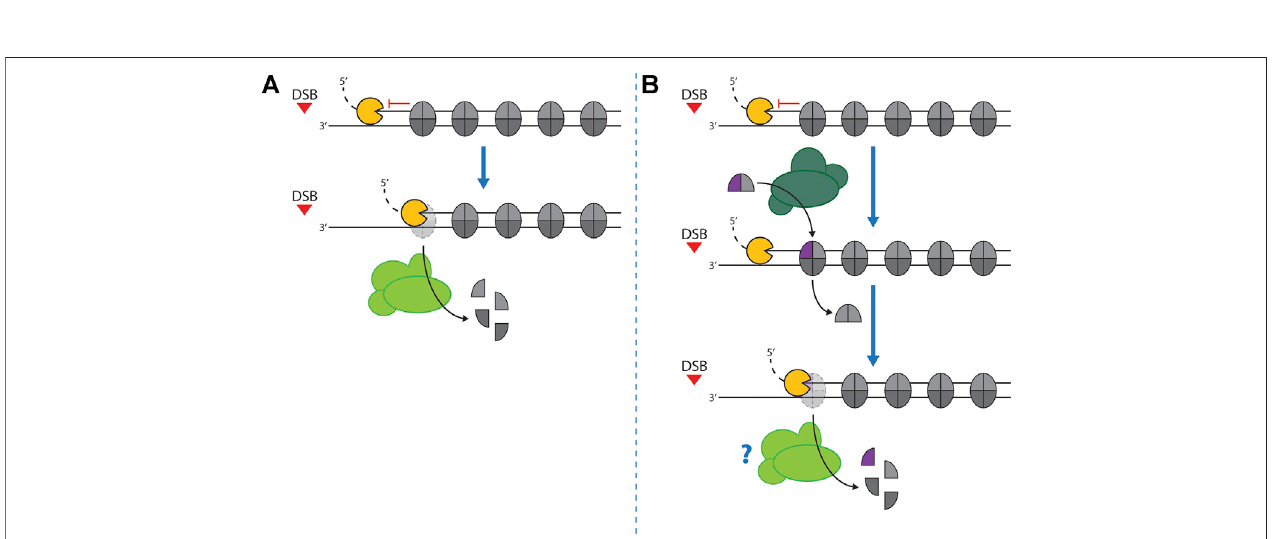
FIGURE 3 | Nucleosome eviction at DSBs. (A) – Resection nucleases (Exo1/Dna2) are inhibited by the presence of nucleosomes. Thus, eviction of nucleosomes from dsDNA is required to facilitate resection. This reaction may be catalyzed by nucleosome remodelers with evicting activity (light green). Moreover, binding of the Mre11-C to the DSB ends might be inhibited by nucleosomes (not shown). Therefore, eviction by nucleosome remodelers might be additionally required also for resectioninitiation. (B) – IncorporationofH2A.Z(purple)intonucleosomesbynucleosome remodelerswitheditingactivity (darkgreen)leadstoareducedstabilityof nucleosomes. H2A.Z-containing nucleosomes may therefore be directly evicted by long-range resection nucleases, but nucleosome remodelers with evicting activity (light green) may be additionally involved (see “ ? ” ).